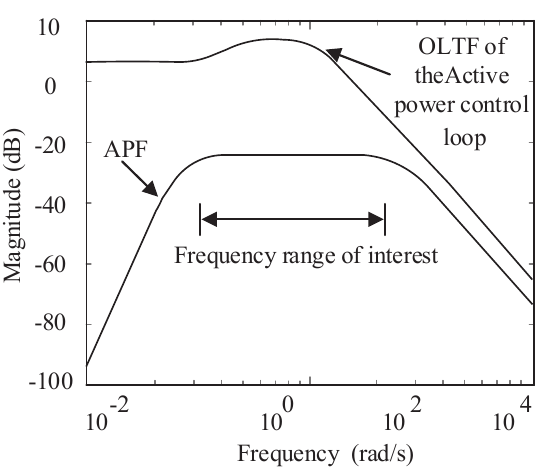
Figure 4. Single-line diagram of the test system.